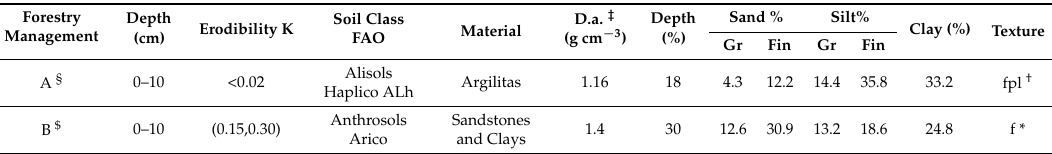
Table 8. Mean values of the physical characteristics of soils.